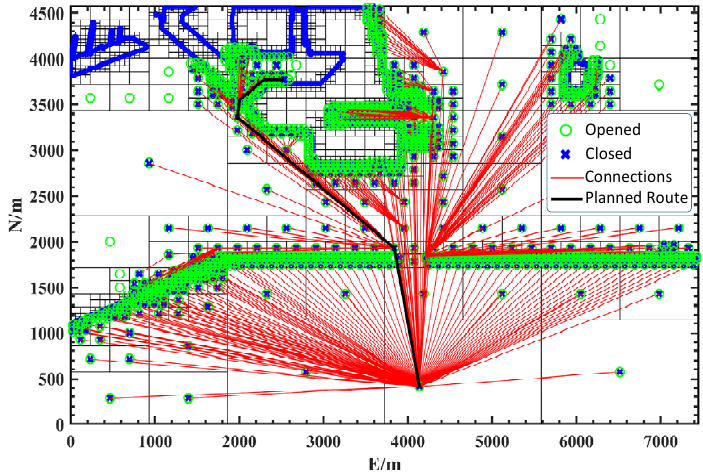
Figure 6. Path planned by modified multi-scale A* algorithm.